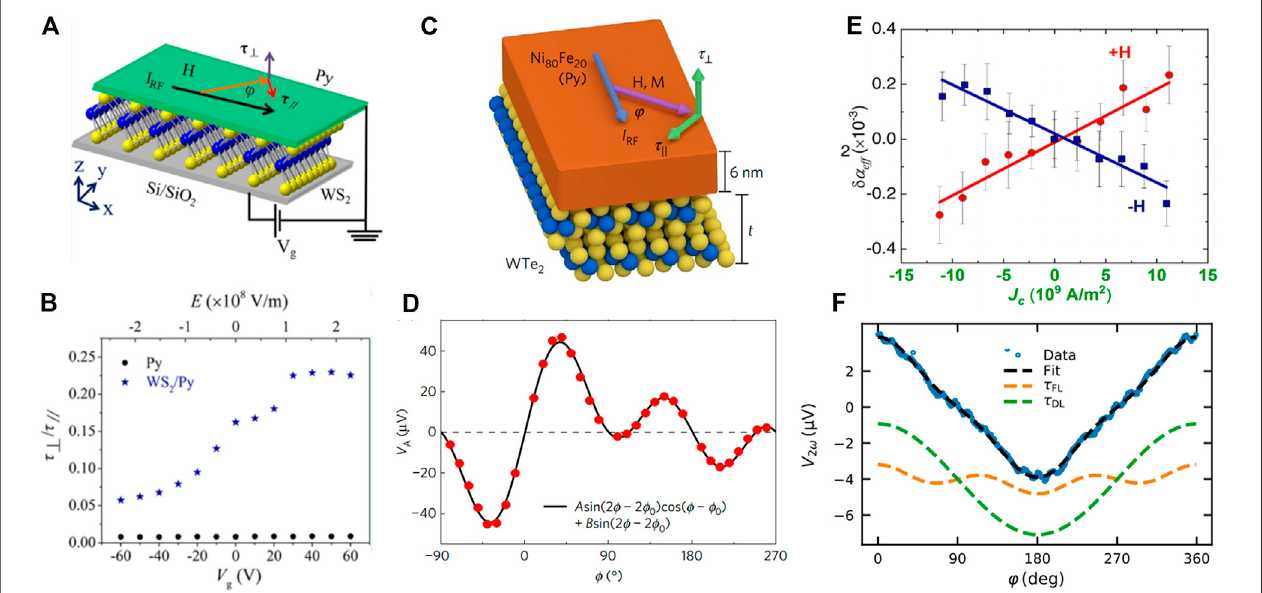
FIGURE2| 2DvdW/FMSOTdevices: (A) SchematicoftheWS 2 /Pyheterostructure(Lvetal.,2018). (B) Theratiobetweentheout-of-plane fi eld-liketorqueandthe in-planedamping-liketorquecontrolledbythegatevoltage. (C) SchematicoftheWTe 2 /Pyheterostructure(MacNeilletal.,2017a). (D) Antisymmetriccomponentsofthe ST-FMR spectra detected at a magnetic fi eld with different directions when the electric current is applied parallel to the low-symmetry crystal axis. (E) DC-induced changesofeffectivedampingintheTaS 2 /Pyheterostructureforpositiveand negative fi elddirections (Husainetal.,2020a). (F) HarmonicHallvoltagedetected ata magnetic fi eld of 34 mT with different angles. Contributions of the damping-like SOT and the fi eld-like SOT are extracted by numerical fi tting, which are shown by green and orange dashed lines (Schippers et al.,